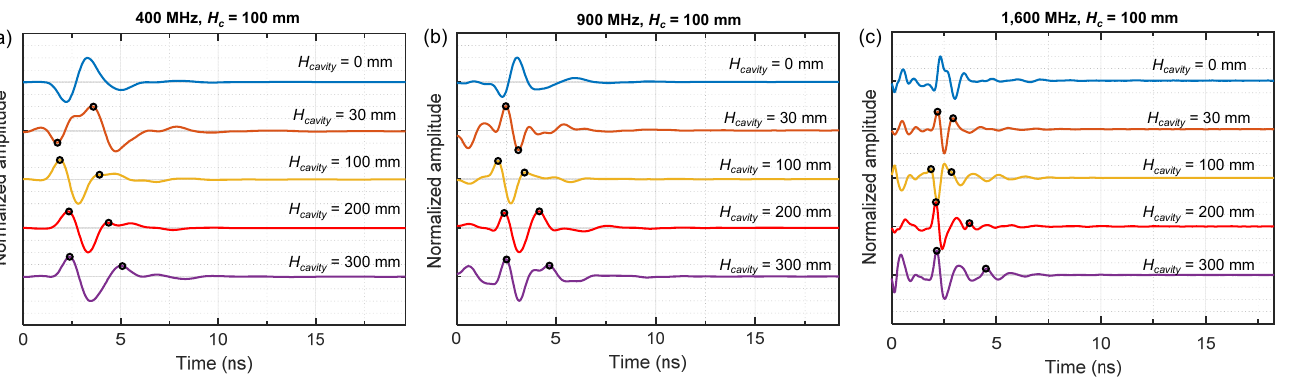
Figure 7. Typical GPR A-scan signals measured over the center of the air-cavities with thicknesses of 30 mm, 100 mm, 200 mm, and 300 mm behind the 100 mm thick concrete by using the three GPR antennas with a center frequency of ( a ) 400 MHz, ( b ) 900 MHz, and ( c ) 1600 MHz. The first peaks of the top and bottom reflections from air-cavities were determined by the improved two-way travel time method, and denoted as open circles in the